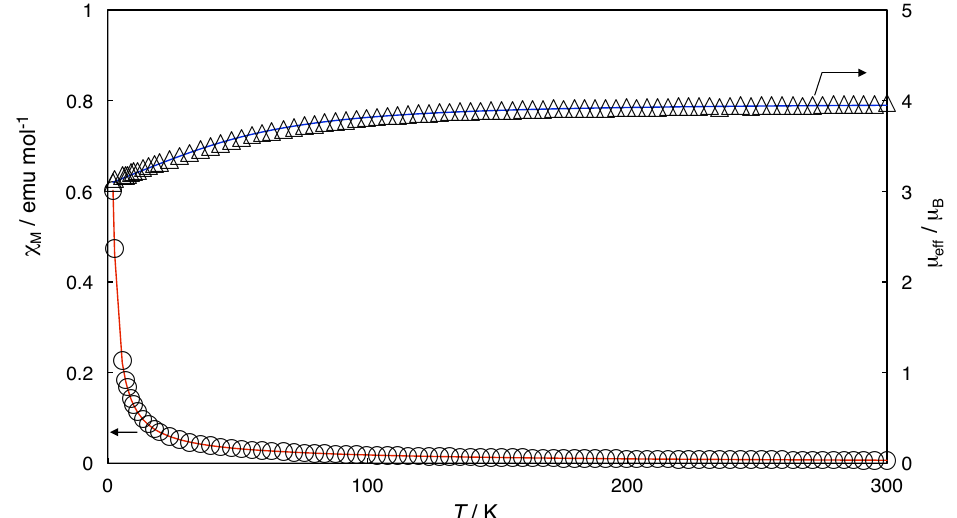
Figure 7. Temperature dependences of magnetic susceptibility χ M (circles) and moment µ eff (triangles) for [Ru 2 (O 2 CC 3 C 7 ) 4 (H 2 O) 2 ]BF 4 ( 3 ). The red and blue solid lines were calculated and drawn with the parameter values described in the